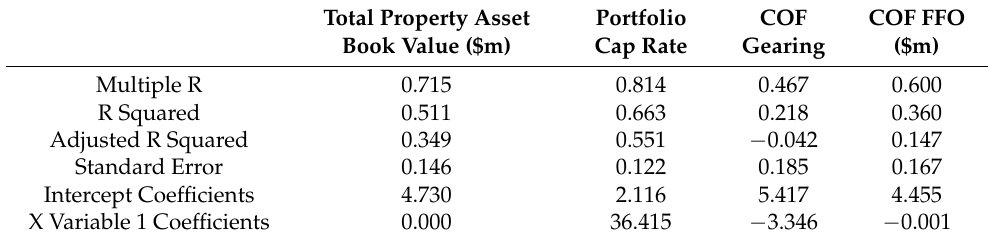
Table 5. Regression results of A-REIT level